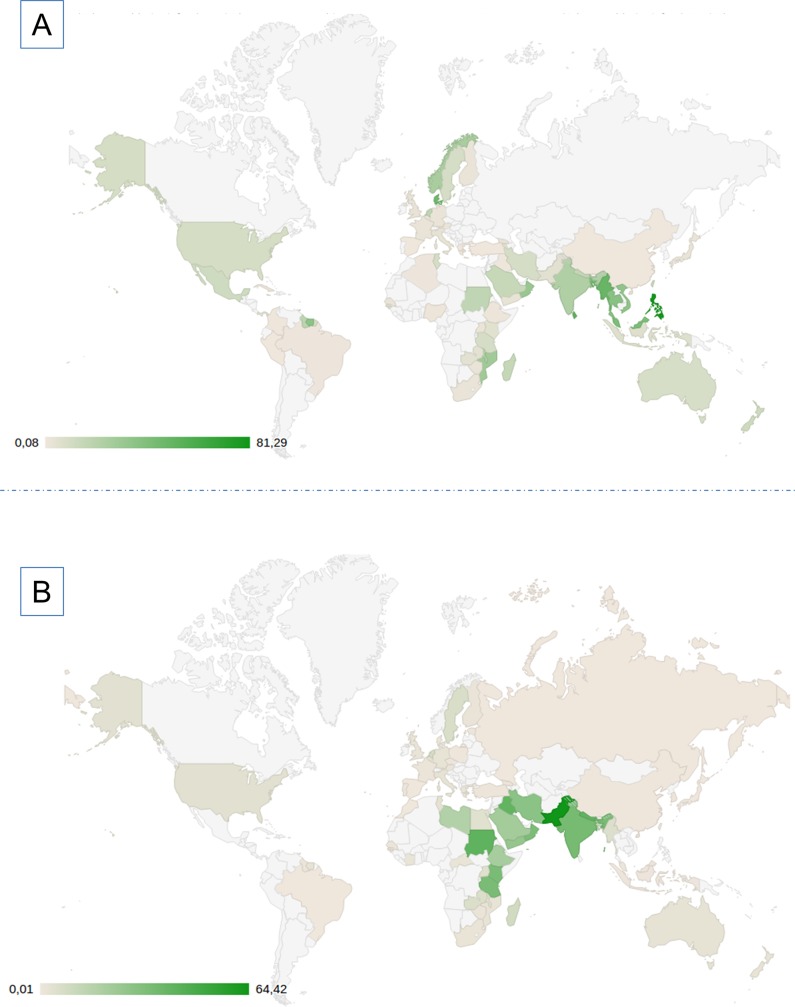
Global Map of distribution (percentage) of EAI (A) and CAS (B) lineages by country of isolation. For better clarification, users can directly and interactively visualize distribution of both EAI (L1) and CAS (L3) lineages on SpolSimilaritySearch’s “Geographical Distribution” web page (http://www.pasteur-guadeloupe.fr:8081/SpolSimilaritySearch/geo.jsp).